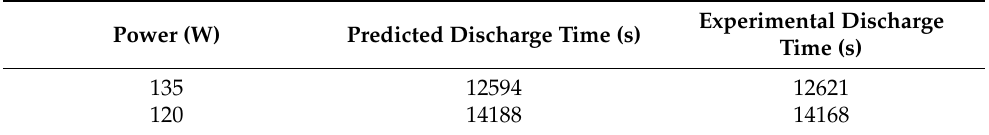
Figure 11. Voltage contrast ( left ) and current contrast ( right ) under constant power conditions. Table 7. Time of constant power discharge.